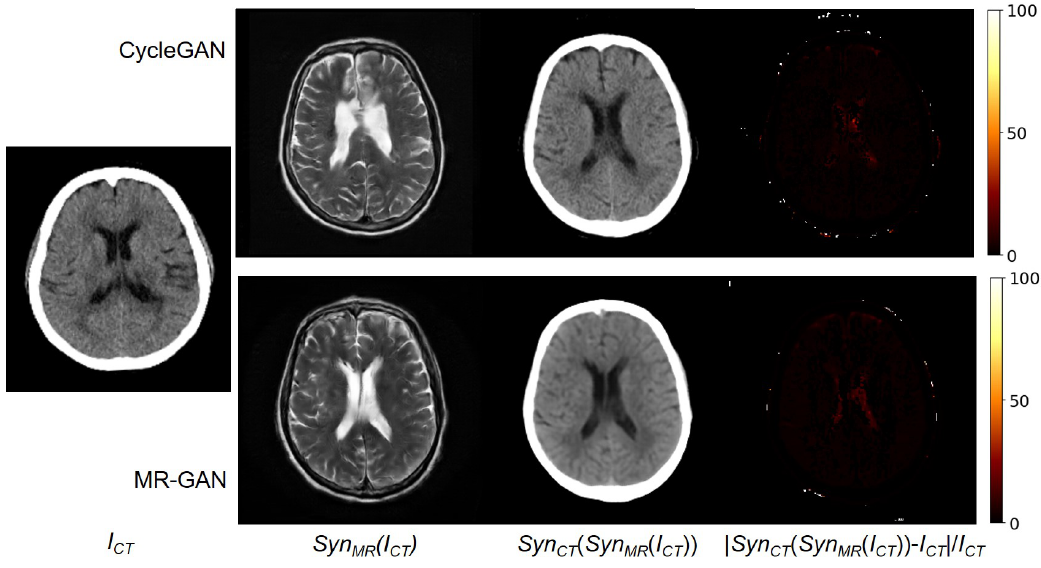
Figure 7. From ( left ) to ( right ): Input CT image, synthesized MR image, reconstructed CT image, and relative difference error between the input and reconstructed CT